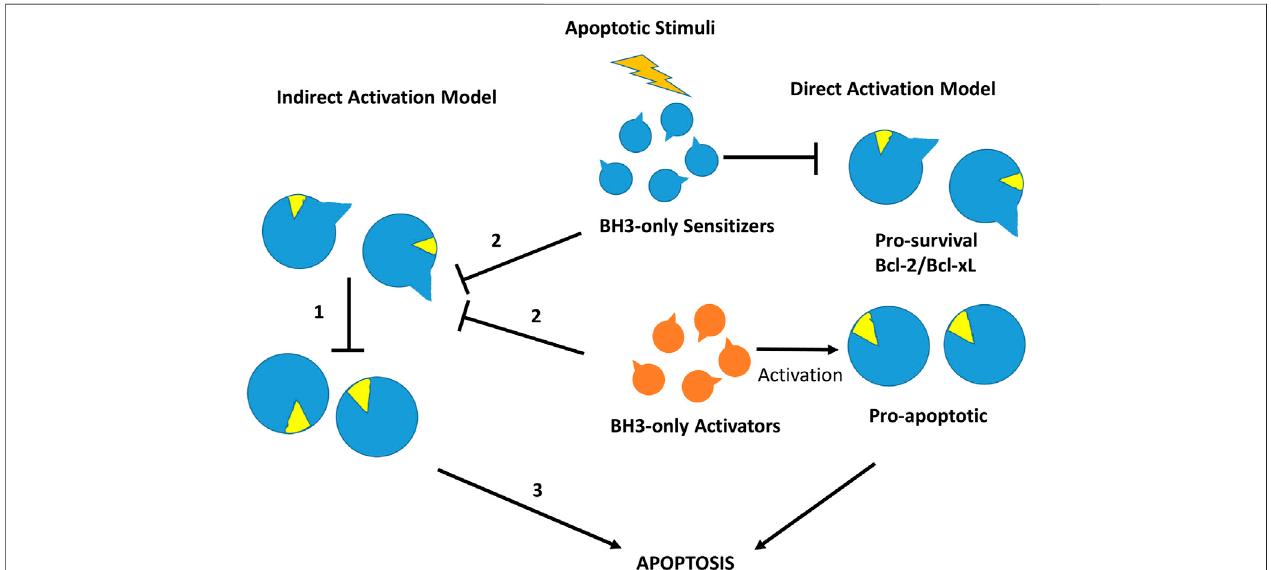
FIGURE 4 | Direct and indirect mechanism models for Bax or Bak activation in the intrinsic cell death pathway. In the indirect activation model (left) , in the resting state effectors Bax and Bak are inhibited directly by pro-survival members (1). After an apoptotic stimulus, BH3-only proteins bind to pro-survival proteins releasing pre- activated Bak and Bax (2) to initiate the apoptosis process (3). In the direct activation model (right) , after an apoptotic stimulus BH3-only activators activate Bak/Bax, whereas BH3-sensitizers inhibit pro-survival Bcl-2 members, initiating the apoptotic process.